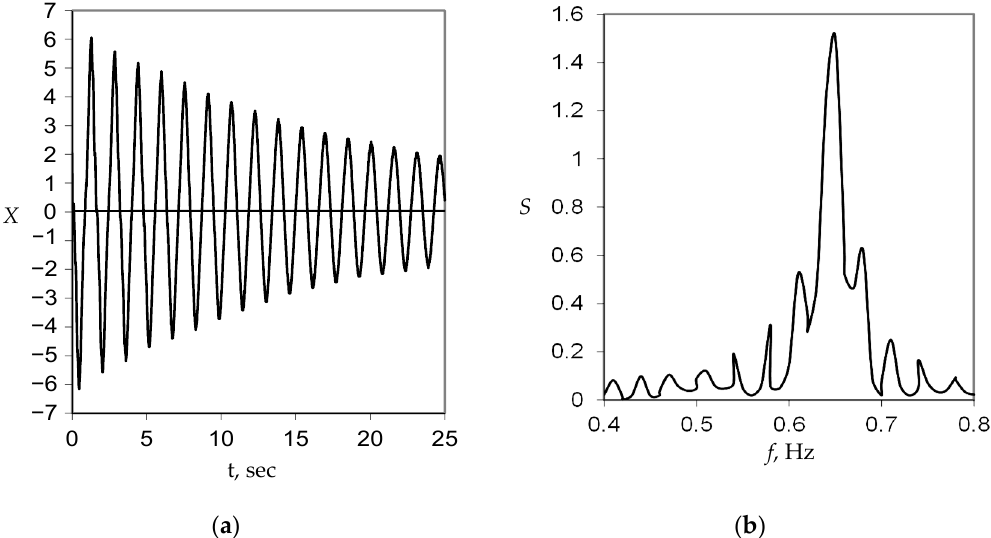
Figure 11. ( a ) Vibration time history of the tested structure; ( b ) corresponding spectra, obtained using FFT for 100 vibration periods.